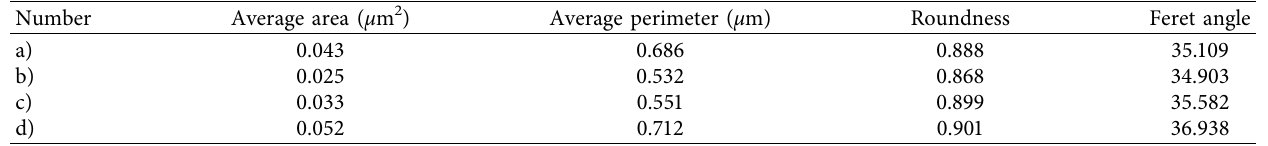
Table 4: Microstructural characteristic data of the samples.